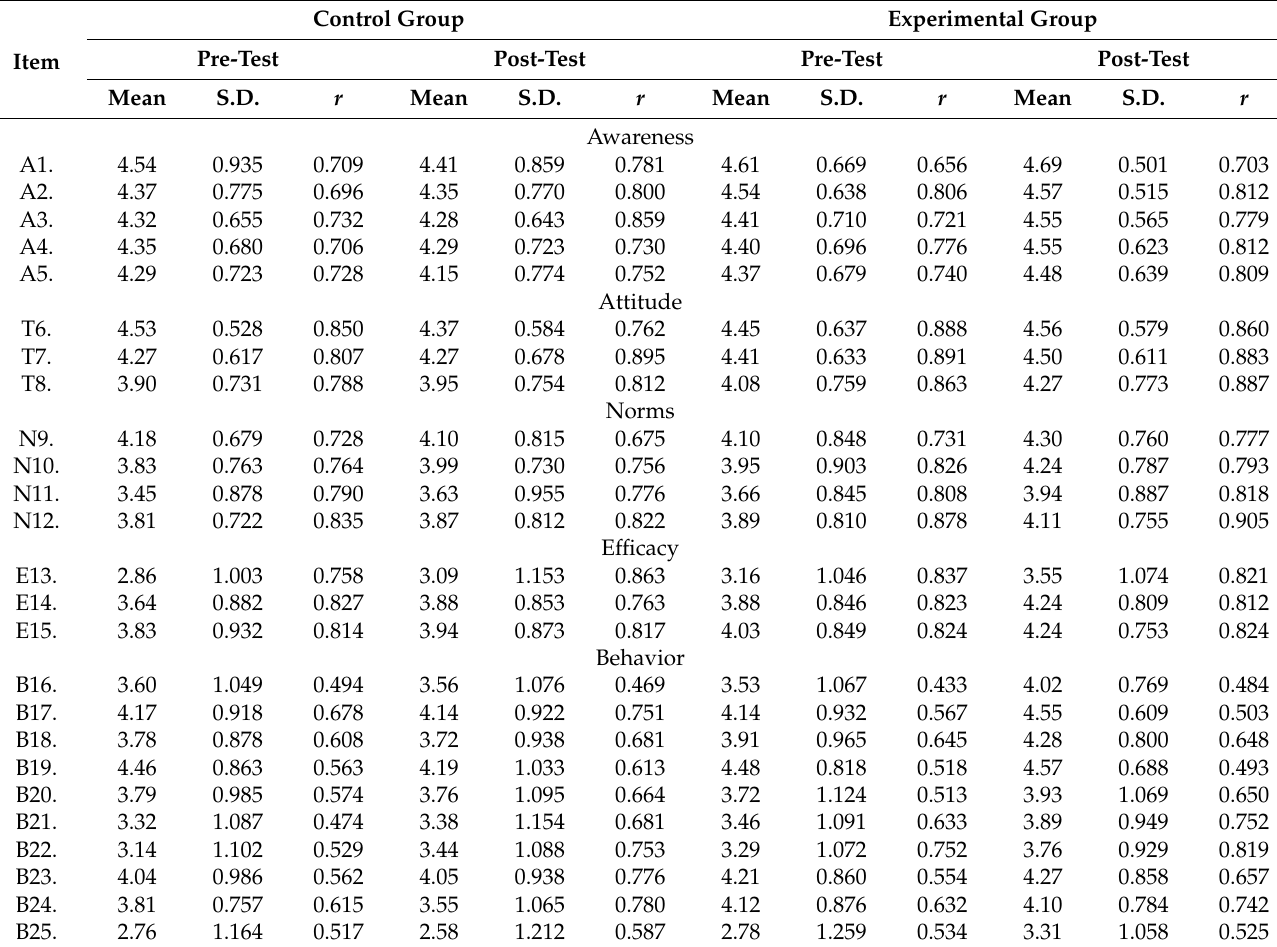
Table 3. Mean and standard deviation of survey